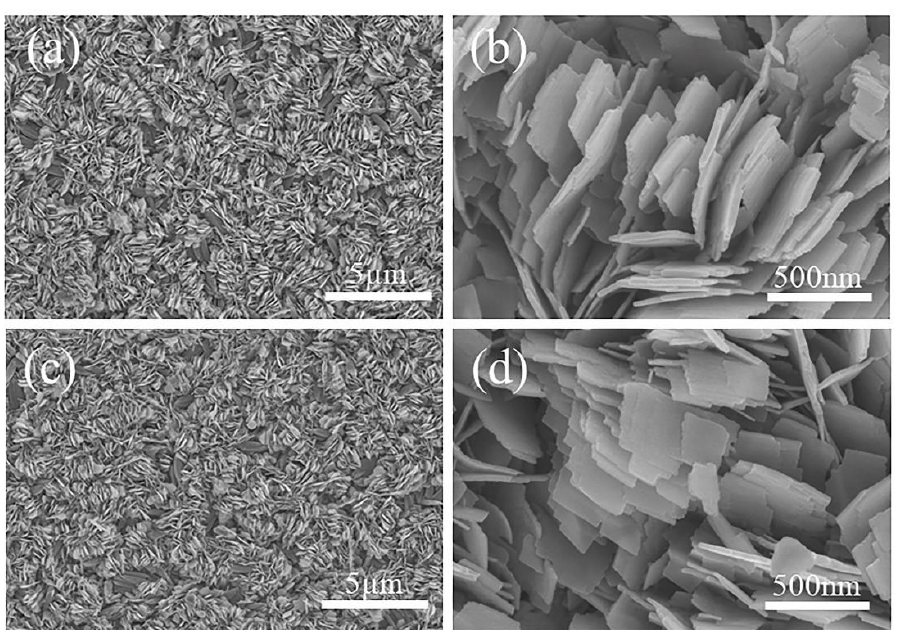
Figure 3. Raman spectra of films N − 400 and N − 450.